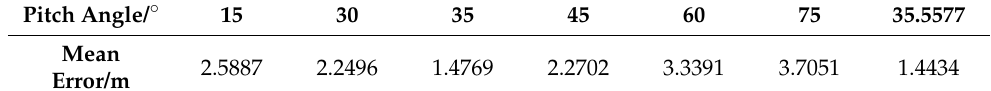
Table 1. Comparison of mean values of positioning errors at different pitch angles.